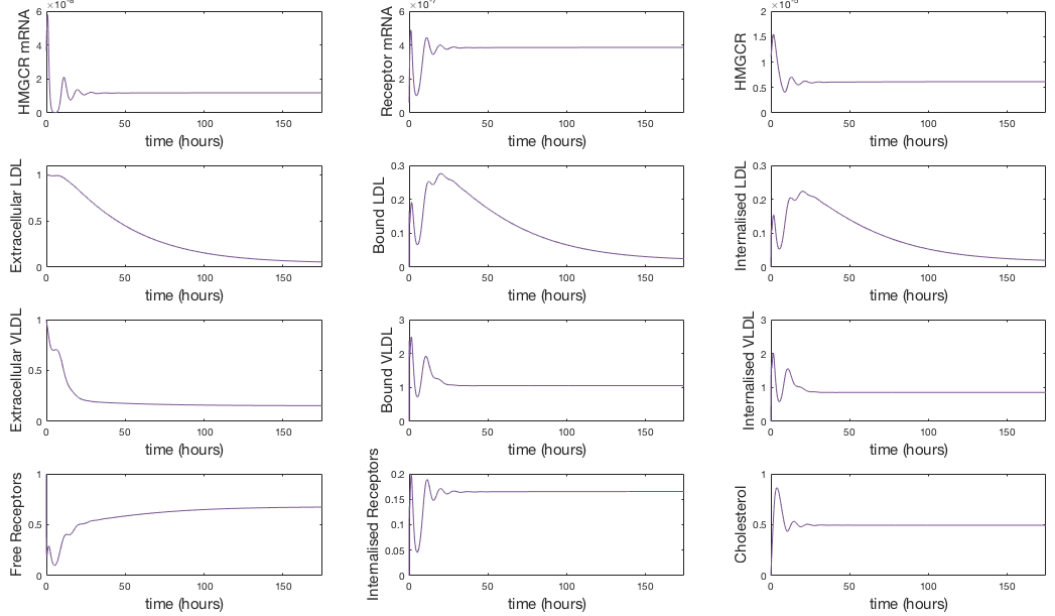
Figure 3. Numerical simulation of Equations (36)–(48). Initially mRNA levels increase in response to zero cholesterol in the system, which leads to an increase in HMGCR and internal receptor levels. VLDL and LDL bind to receptors and are internalised where cholesterol is extracted. The increase in HMGCR and extraction of cholesterol from internalised lipoproteins cause intracellular cholesterol concentrations to increase. Damped oscillations can be seen as HMGCR mRNA responds to changing cholesterol concentrations and the receptor mechanism responds accordingly. Following this initial transient behaviour, the molecular and cholesterol parts of the system settle to a relatively stable steady-state whilst VLDL and LDL continues to be extracted from the extracellular environment until a final steady-state is